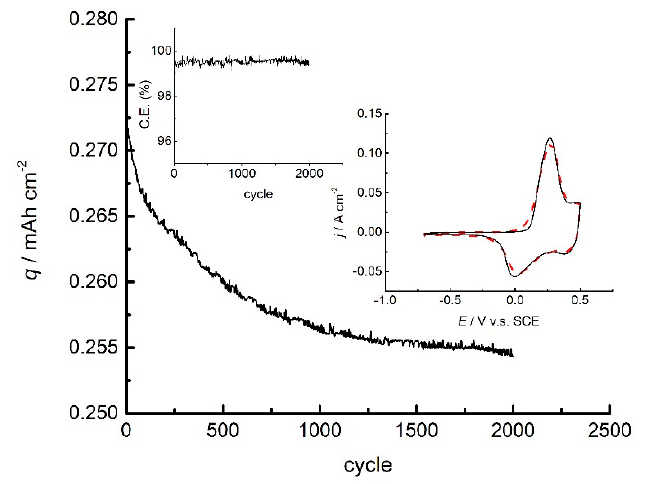
Figure 11. The capacity of PANI electrode over 2000 cycles of successive charge/discharge at 9.5 A g − 1 to charge potential limit of 0.5 V. Insert: cyclic voltammograms before (full line) and after (dashed line) cycling and Coulombic efficiency over 2000 cycles.